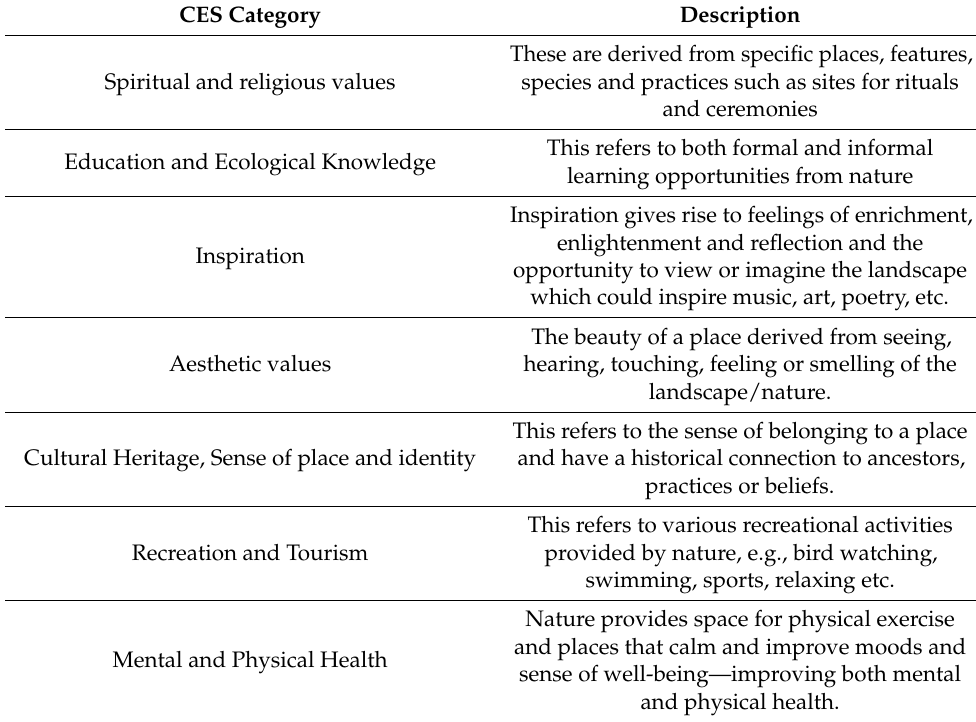
Table 1. Cultural Ecosystem Services (CES) assessed in this